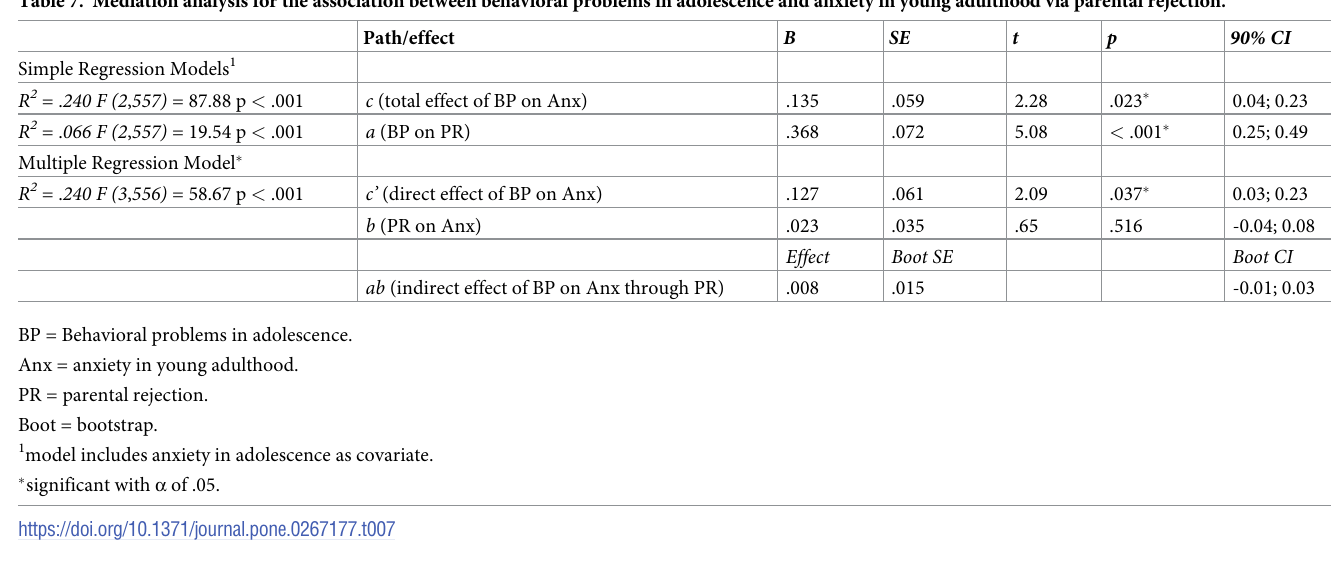
into account (see Table 8 and Fig 2).